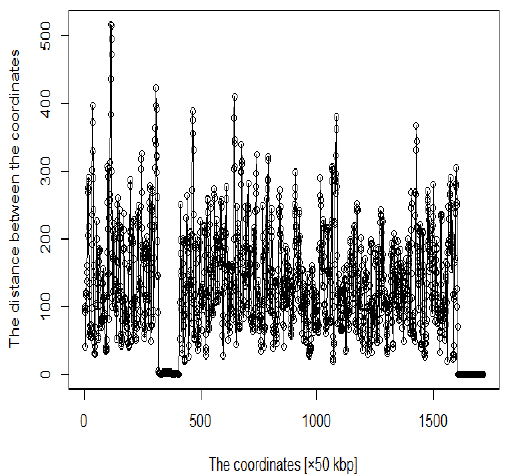
Figure 7. Distance plot between coordinates by StoHi-C.